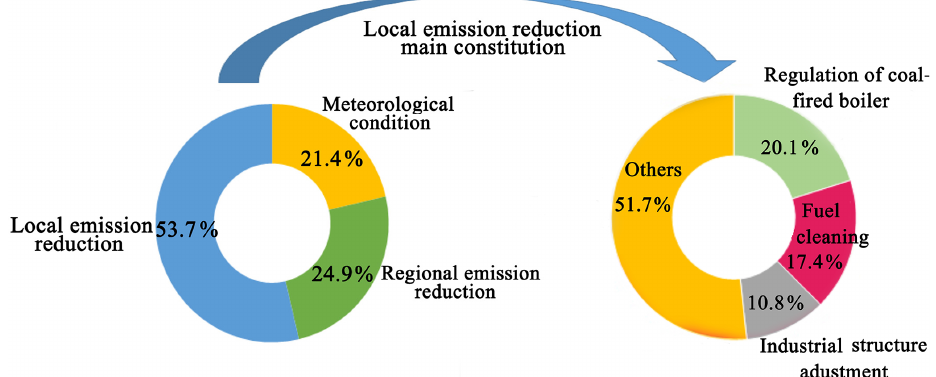
Figure 5. The relative contribution of different influencing factors to the decrease in PM 2 . 5 concentrations in Beijing from 2013 to 2017.